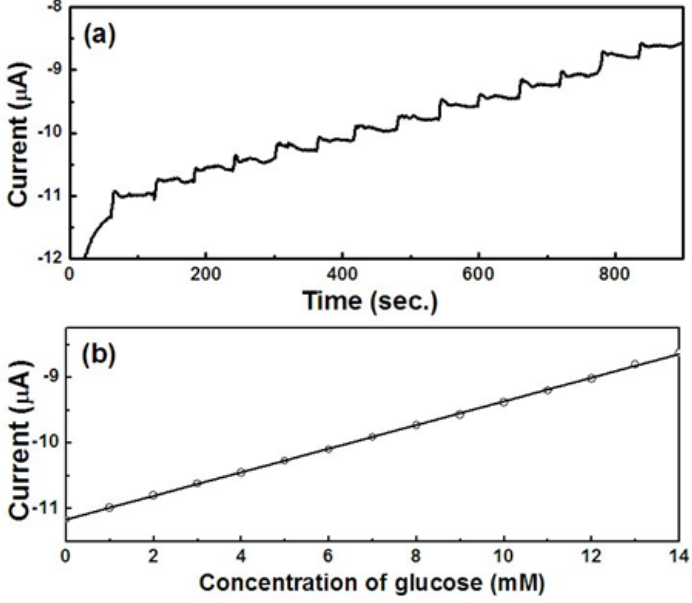
Figure 13. ( a ) Amperometric responses and ( b ) calibration plot (current vs. concentration of glucose) with linear regression analysis of hexapod Au/Cu NaOH at an applied potential of −600 mV and with successive additions of 1 mM